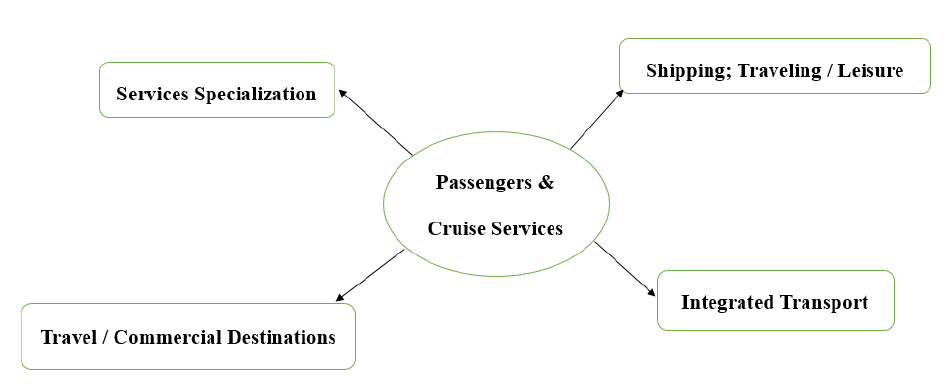
Figure 4. Chart of sea toll elements for passenger services and cruise. Source: Indonesian Main Sea-Corridor [13].